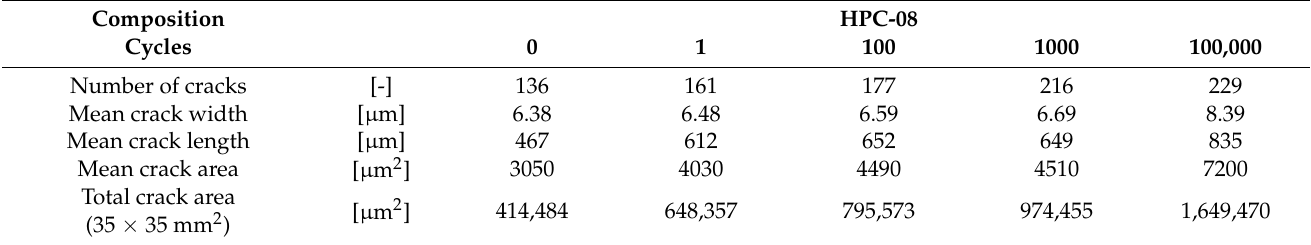
Table 6. Microscopic analysis of